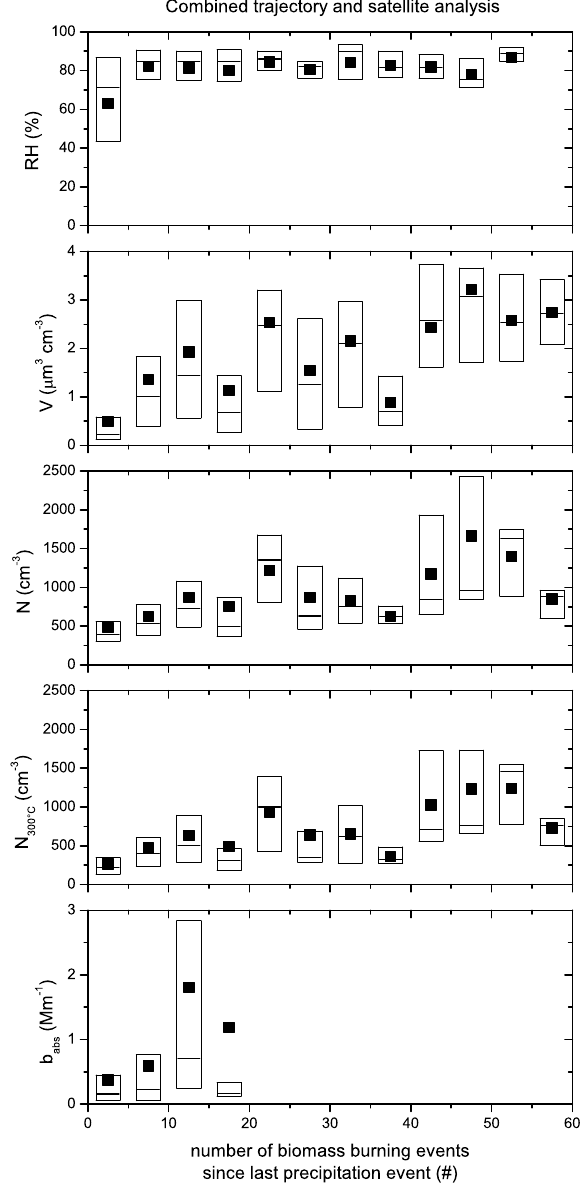
Fig. 6. Relative humidity RH (%), ambient particle volume concen- tration V (D p = 10–470nm) (µm 3 cm − 3 ), ambient aerosol number concentration N (cm − 3 ), refractory particle number concentration N 300 ◦ C (cm − 3 ), and absorption coefficient b abs (Mm − 1 ) versus the number of fire events detected since the last precipitation event according to the trajectory analysis (-10 days).